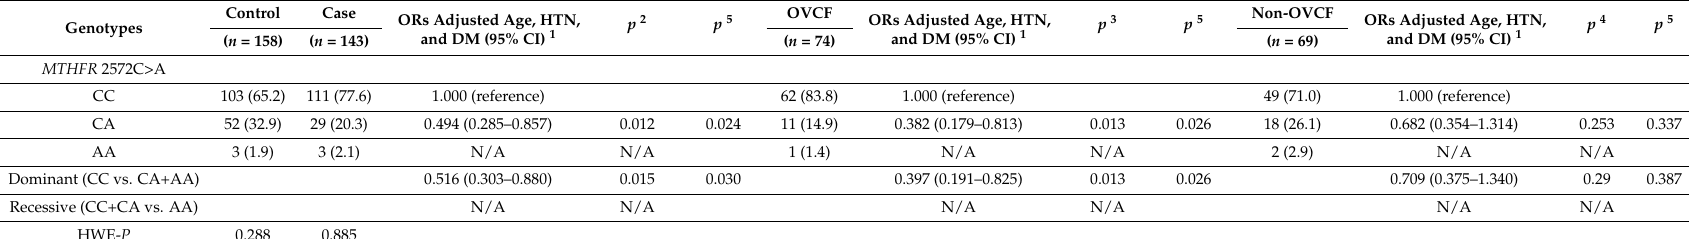
Table 2. Genotype frequencies of methylenetetrahydrofolate reductase ( MTHFR ) and thymidylate synthase ( TS ) gene polymorphisms in